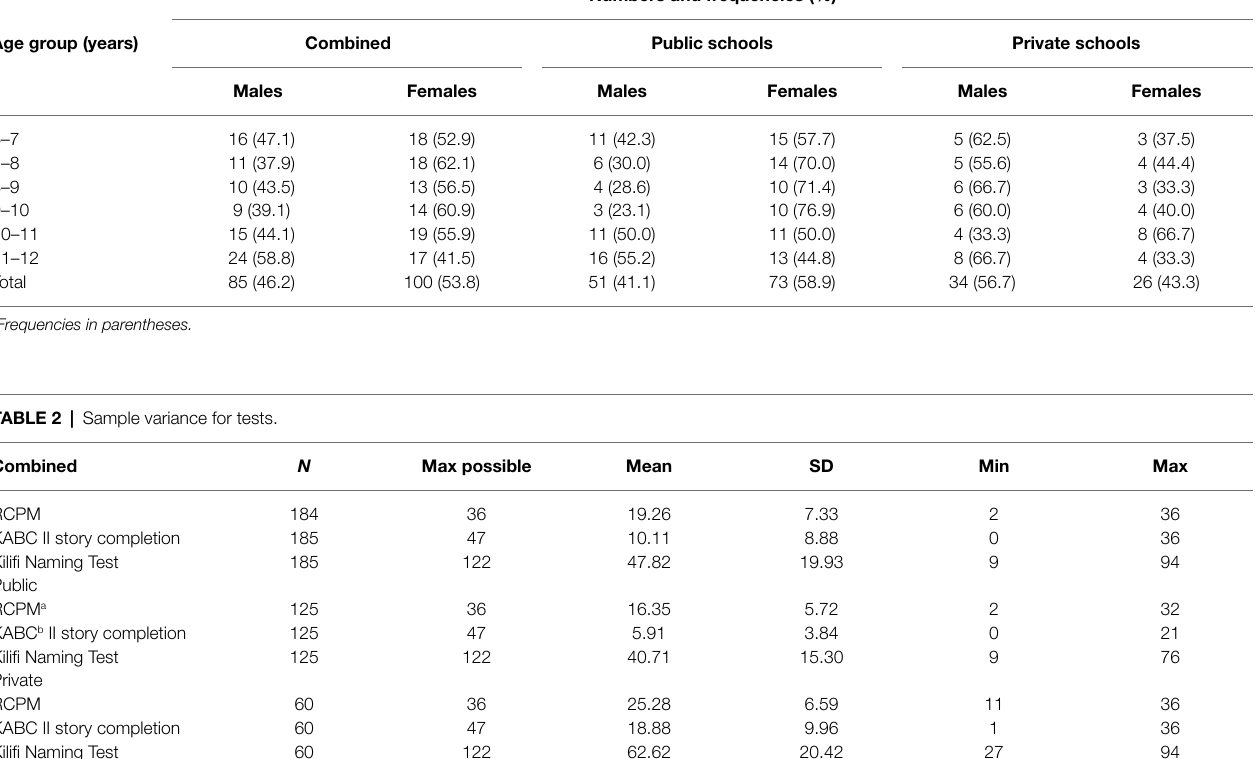
Age group (years)